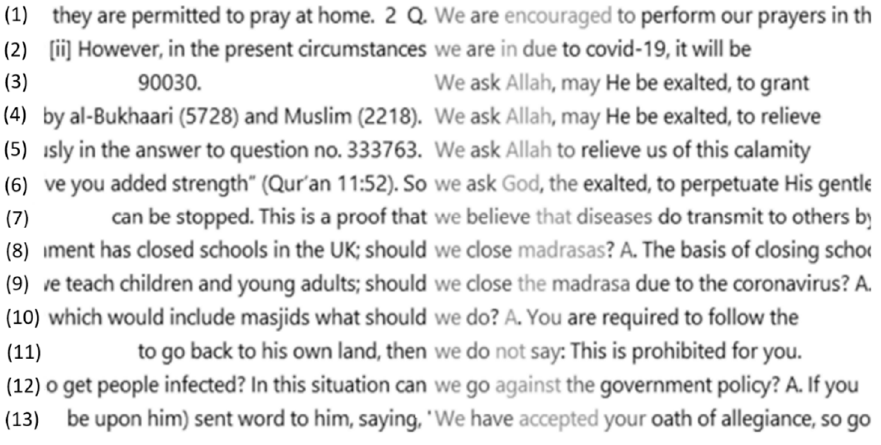
Figure 6. We in the